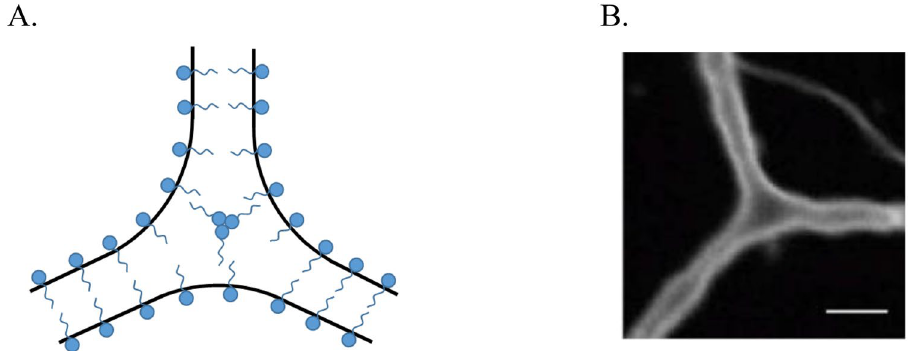
Figure 1. Movable network junctions. ( A ) A sketch illustrating a three-way junction in a planar soap froth network. ( B ) Three-way junction between dilated ER tubules formed with Xenopus egg membranes 6 (Scale bar: 3